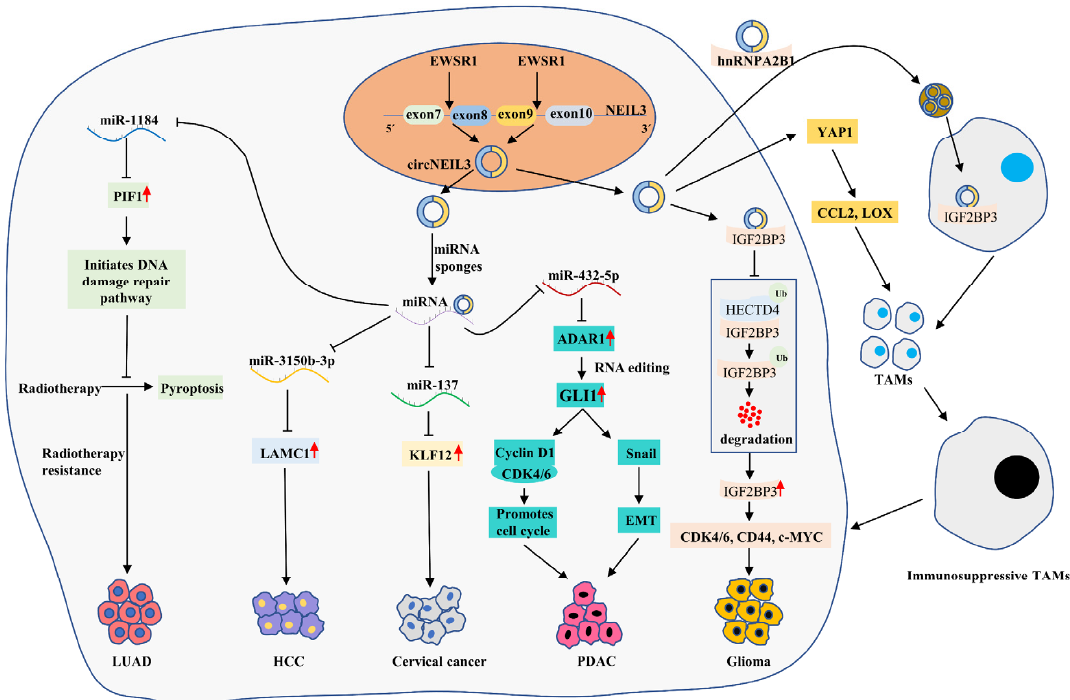
Figure 5. A schematic diagram of circNEIL3 promoting the malignant progression of LUAD, HCC, cervical cancer, GBM and PDAC. EWSR1 promotes the cyclization of circNEIL3 by binding to exons 8 and 9 of NEIL3 pre-mRNA. circNEIL3 promotes HCC progression by regulating the circNEIL3/miR-3150b-3p/LAMC1 axis. circNEIL3 significantly inhibits the generation of radiotherapy-induced LUAD cell pyroptosis and promotes carcinoma cell growth by regulating the circNEIL3/miR-1184/PIF1 axis. circNEIL3 promotes cervical cancer cell proliferation by regulating the circNEIL3/ miR-137/ KLF12 axis. circNEIL3 promotes glioma proliferation, invasion and migration by regulating the circNEIL3/HECTD4/IGF2BP3 axis, and it also induces the massive aggregation of immunosuppressive TAMs in the tumor microenvironment by activating the YAP1 and exosome pathways. circNEIL3 promotes cell cycle progression and EMT through regulation of circNEIL3/miR-432-5p/ADAR1/GLI1 axis, ultimately promoting PDAC proliferation, migration and invasion.